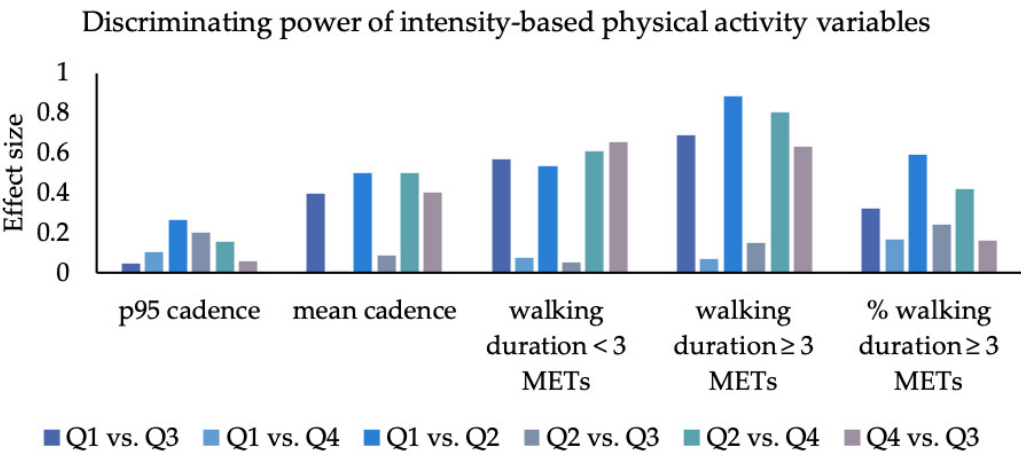
Figure 2. Effect size for each group comparison for intensity-based PA variables: Q1: 1. quadrant